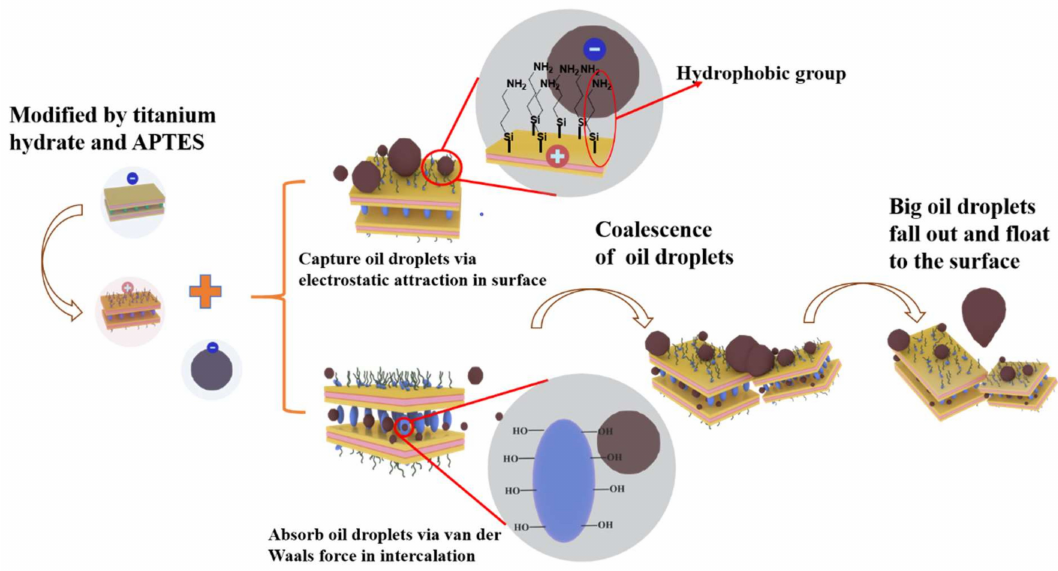
Figure 13. Schematic illustration of the demulsification